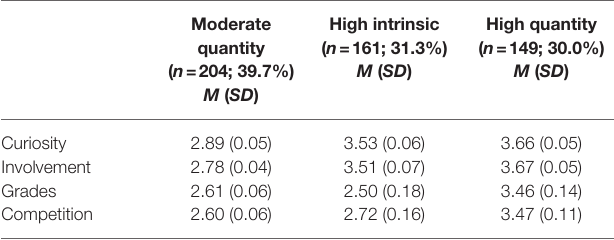
TABLE 5 | Profile differences on amount of reading for enjoyment and for